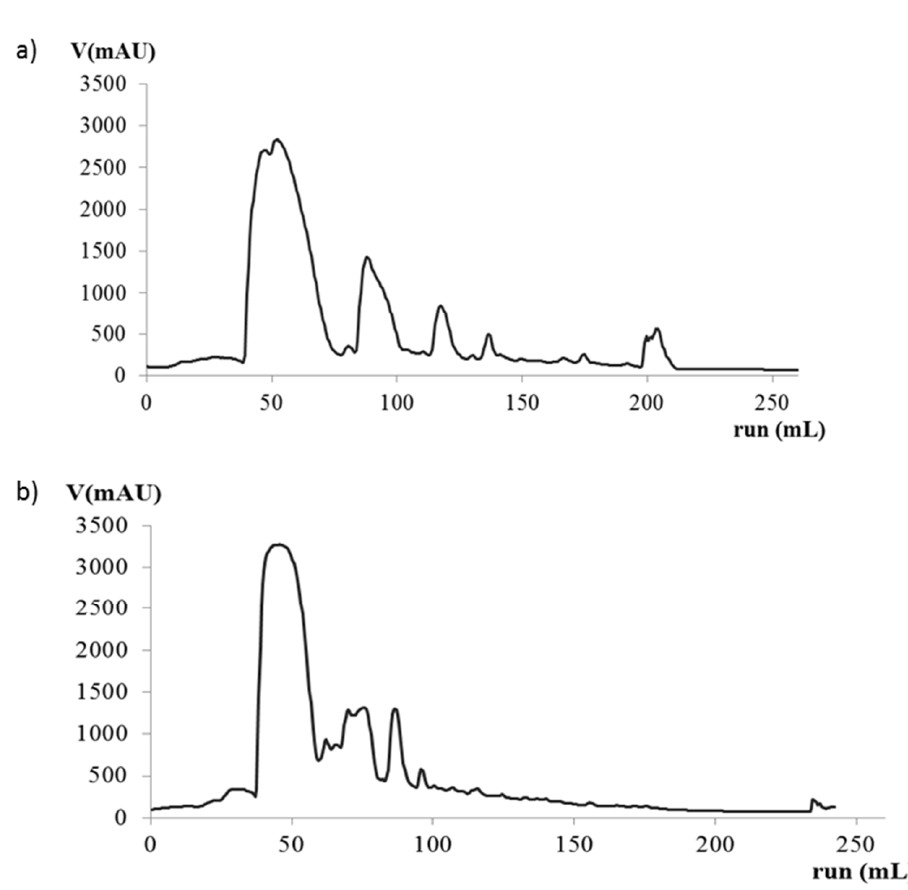
Figure 4. FPLCprofile of HCAs elution with ( a ) methanol and ( b ) ethanol as